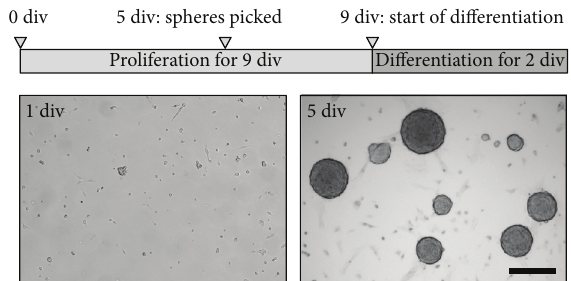
Figure 1: Time schedule of enterosphere culture. The timeline illustrates the schedule of in vitro culture. Cells were isolated at 0 div (days in vitro ) and proliferated for 5 days. Spheres were then picked and again proliferated for 4 days. At 9 div, enterospheres were picked, washed, transferred to differentiation medium, and incubated for 2 days before gene expression analyses were carried out. The micrographs show proliferating enterospheres after 1 and 5 div. Scale bar: 200 𝜇